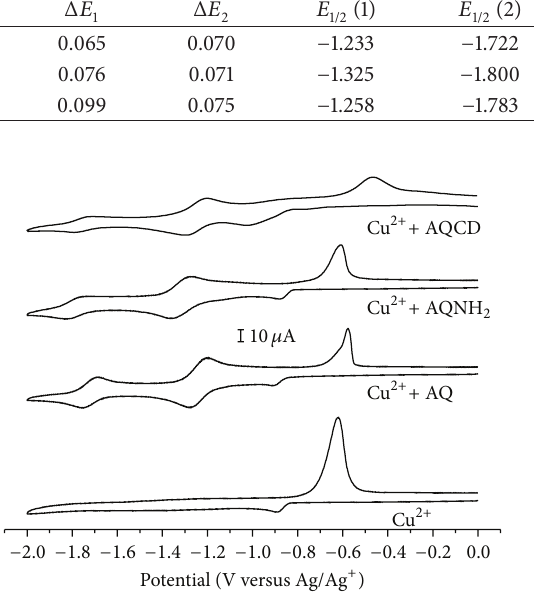
Figure 2: CVs of 0.5 mM AQCD in the absence and presence of 0.25, 0.5, and 0.75 mM Cu 2+ in 0.1M TBAPF 6 /CH 3 CN. Scan rate: 50 mV/s.